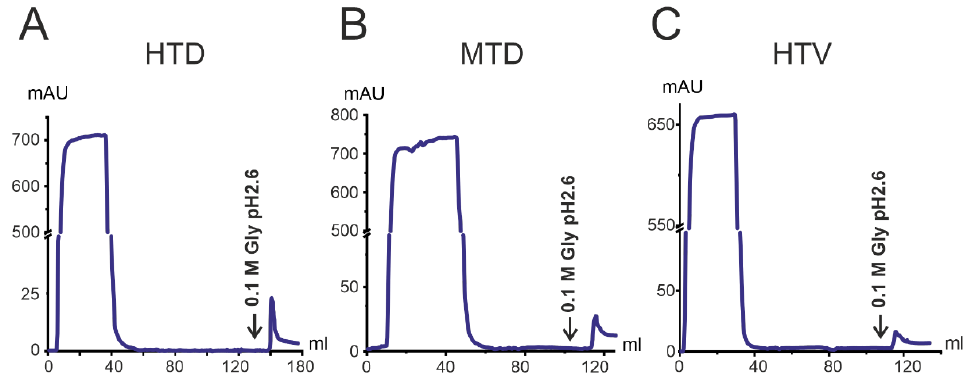
Figure 2. Isolation of anti-RBD-IgG by affinity chromatography of total IgGs on RBD-Sepharose: ( A ) HTD, ( B ) MTD, and ( C ) HTV. Antibodies with different affinities for RBD were eluted with 0.1 M glycine pH 2.6.